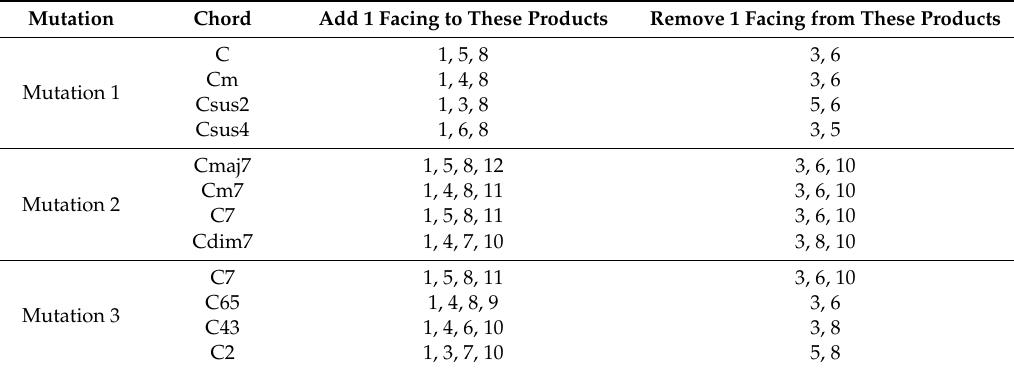
Table 2. Mutation rules for adding and removing